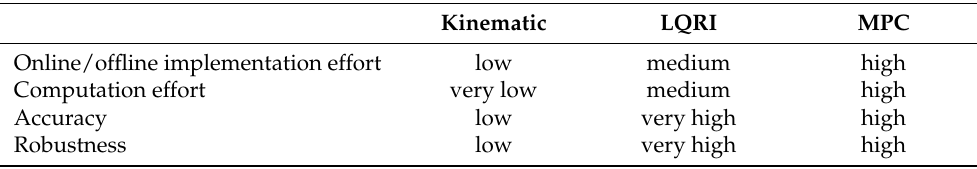
Table 6. Advantages and disadvantages of the examined